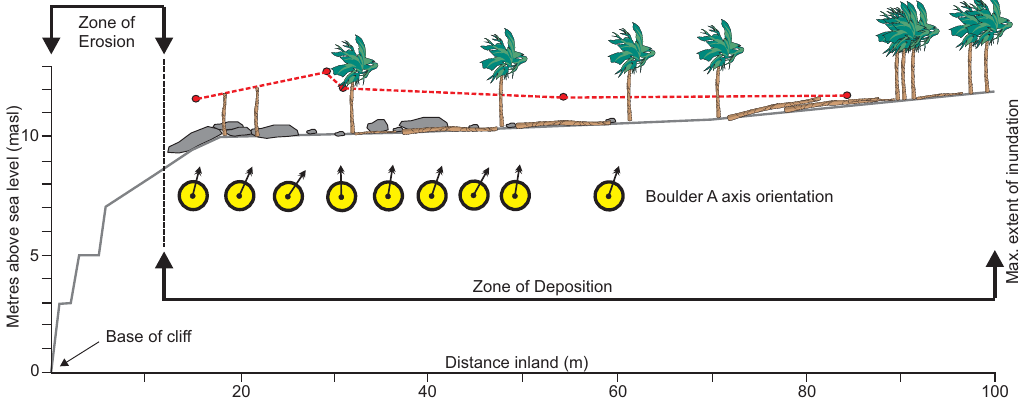
Fig. 3. Point 3: transect perpendicular to coast marking the zones of erosion and deposition. Most boulders cluster near the main break of slope, but can be traced inland about 60m. The red dashed line joins up points where (minimum?) flow depths were noted. Variations in the A-axis orientation of individual boulders are